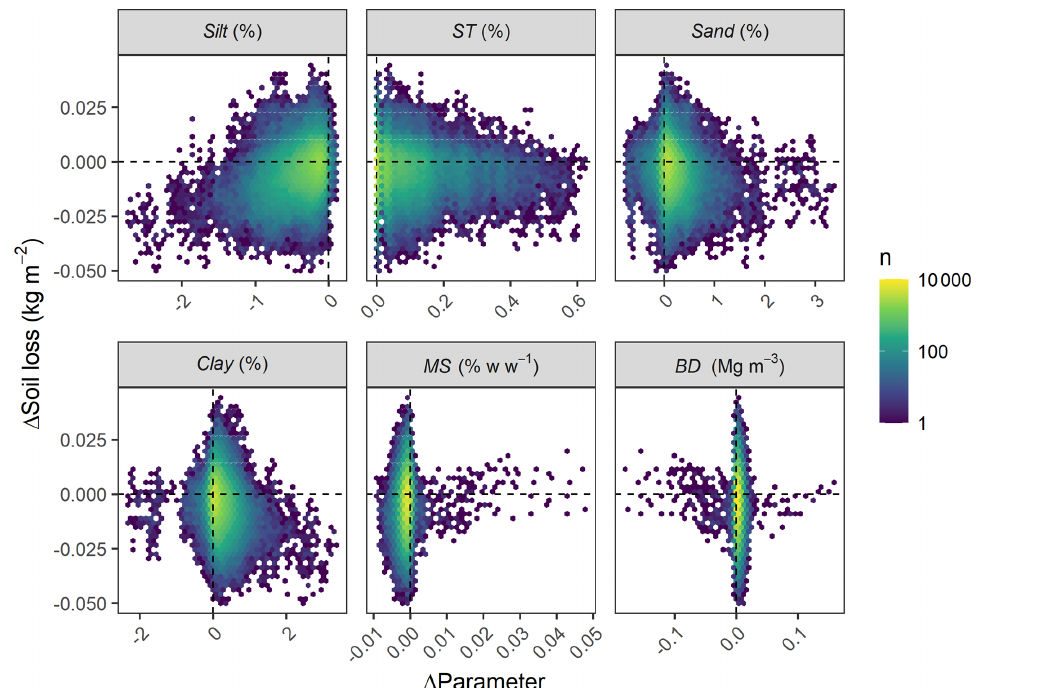
Figure 8. Hexagonal heatmaps relating the changes in model parameters to soil loss responses over 10-year rolling means for the soil profiles. Colours represent the number ( n ) of cases in each